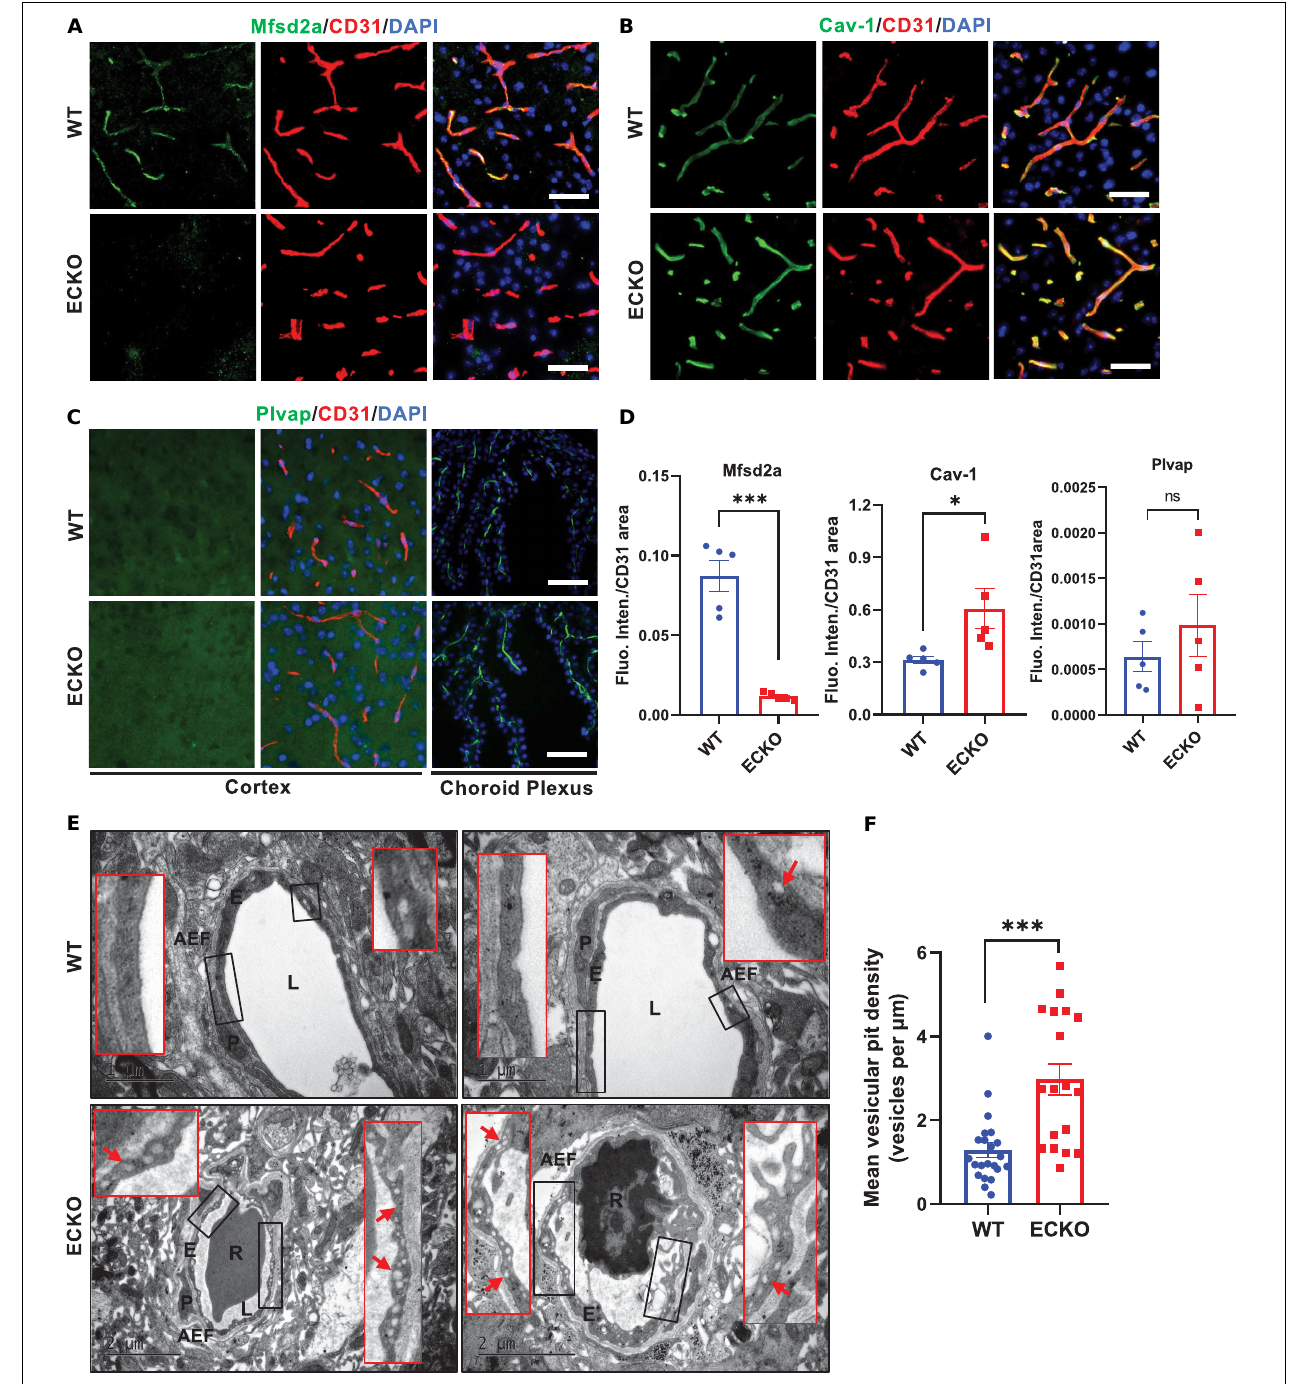
FIGURE 4 | Endothelial cell-specific deletion of β -catenin substantially increases caveolae-mediated transcytosis via downregulating Mfsd2a. (A,B) Immunofluorescence staining showing the expression levels of Mfsd2a and Cav-1 in the cerebral cortex from β -cat WT mice and β -cat ECKO mice, respectively. Scale bars: 100 µ m. (C) No Plvap staining was observed in the cerebral cortex of both β -cat WT (upper panel) and β -cat ECKO mice (lower panel). Choroid plexus was used as a positive control to show Plvap staining signal. Scale bars: 100 µ m. (D) Quantifications of the fluorescence intensity of Mfsd2a, Cav-1, and Plvap normalized with CD31 area, respectively. (E) Representative TEM images from WT control (upper panel) and ECKO mice (lower panel). Red boxed images show magnified versions of black-boxed images. Arrows indicate endothelial vesicles in β -cat WT control (upper panel) and β -cat ECKO mice (lower panel). AEF, astrocyte end-feet; E, endothelial Cell; L, lumen; P, pericyte; R, red blood cells. Scale bars: 1 or 2 µ m. (F) Quantification of mean vesicular pit density in both β -cat WT and β -cat ECKO mice. Data are mean ± SD. n = 4 mice per group, each data point represents one microvessel examined, totally > 18 microvessels per group. Significance of data is represented as: ns = not significant, P > 0.05, ∗ P < 0.05, ∗∗∗ P < 0.001.